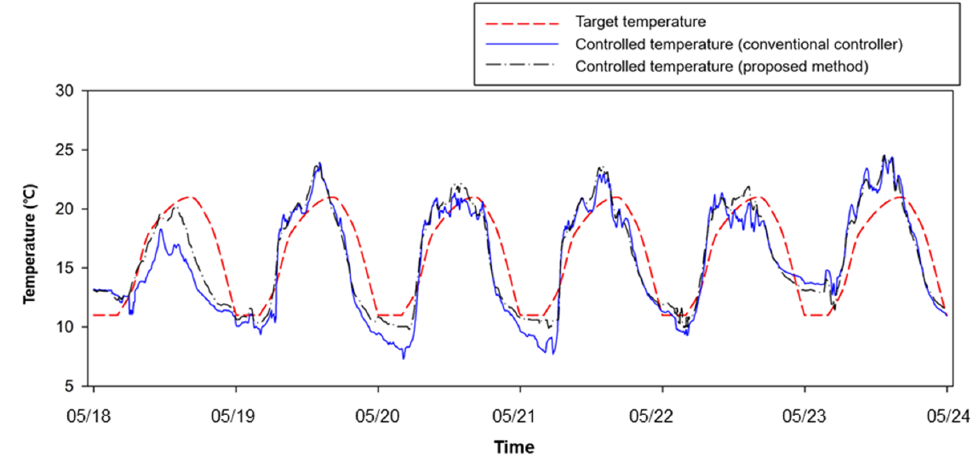
Figure 11. Field test results for the proposed method from 18 May to 24 May.